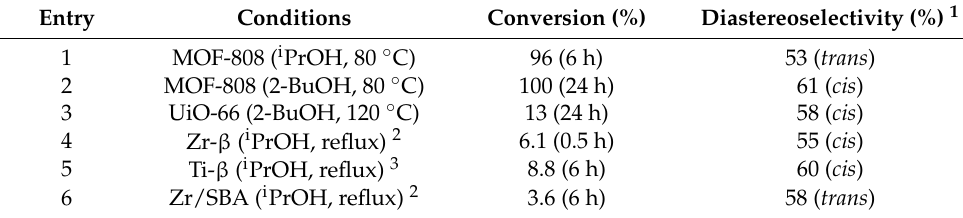
Table 2. MPV reaction of 2MeCH = O over various heterogeneous